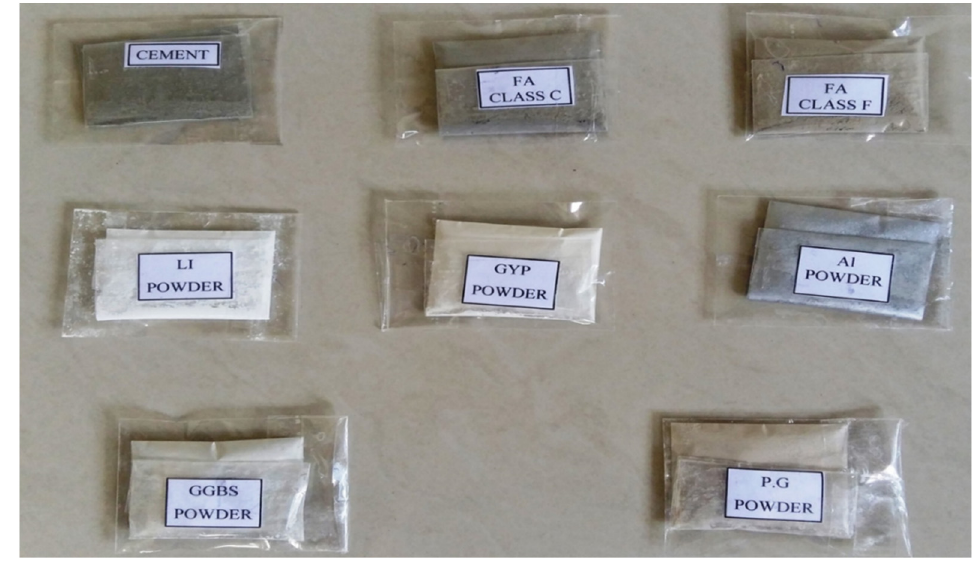
Figure 8. Raw materials used in AAC.